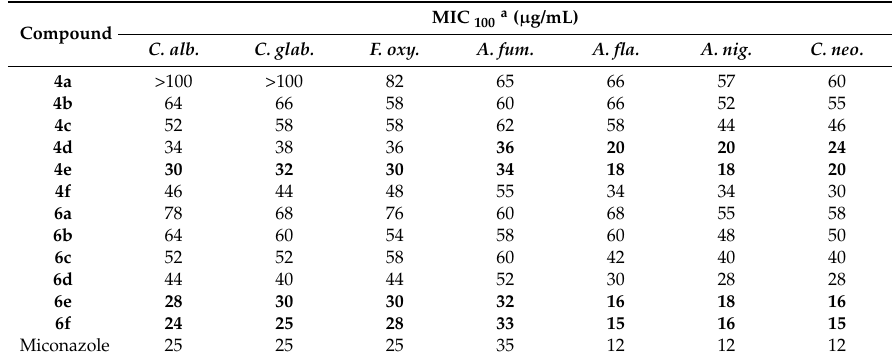
Table 6. In vitro antifungal activity of the synthesized compounds 4 ( a – f ) and 6 ( a – f ). MIC 100 a ( µ g/mL) Compound C. alb. C. glab. F. oxy. A. fum. A.